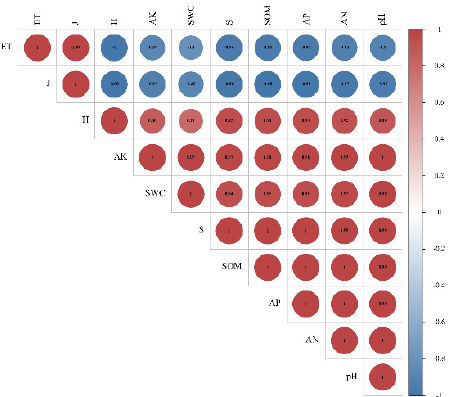
Figure 12. Correlations of soil characteristics and plant community species diversity index.